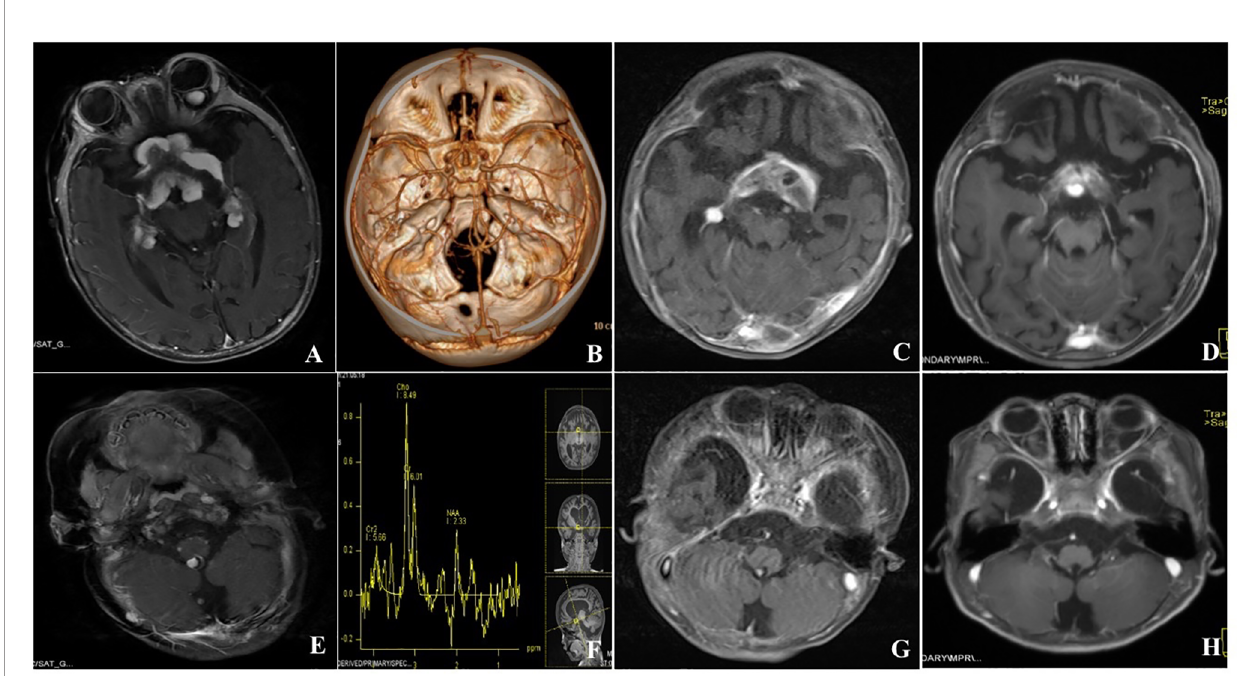
FIGURE 2 | Gd-enhanced cranial MRI depicted multiple enhanced lesions in the suprasellar cistern, bilateral cavernous sinus and hippocampus, intraorbital and cisterna magna (A, E) . CT angiography showed that the lesions were not vascular tumors and no obvious vessels were found inside the tumor (B) , MR Spectroscopy showed that the lesion in the saddle area was featured by an elevated choline peak, a reduced NAA peak and a lactate peak (F) . Postoperative MRI depicted partial resection of suprasellar cistern tumors (C, G) . Further MRI was done at 22 months follow-up depicted spontaneous regression of the lesions in the medial hippocampus, suprasellar cistern, and cisterna magna (D, H)